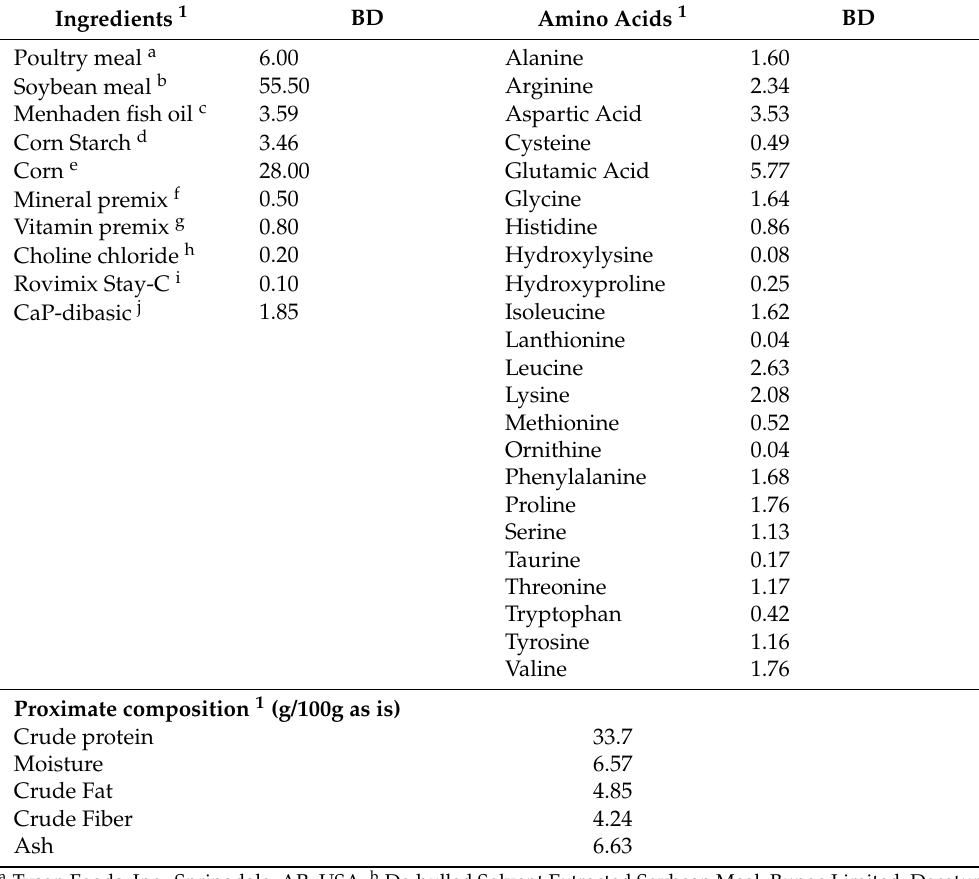
Table 1. Formulation and proximate composition of basal diet (BD) used in the feeding trials (% as